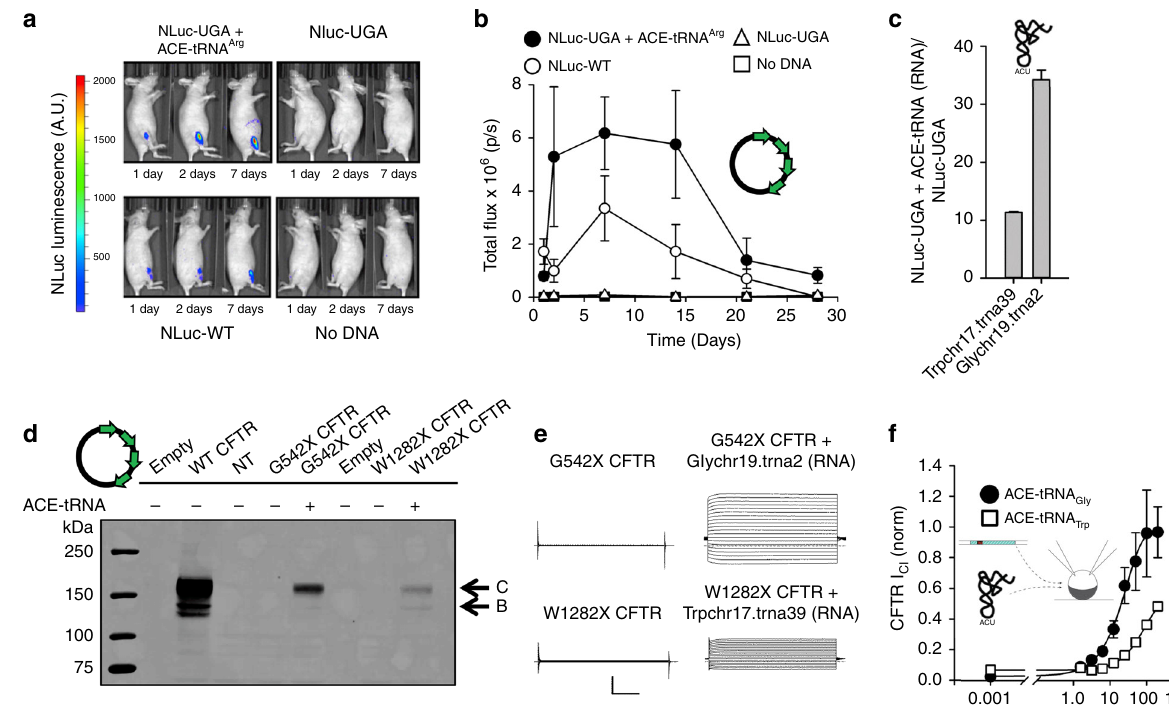
Fig. 5 In vivo delivery and suppression with ACE-tRNA as cDNA and RNA. a Representative images of mice injected with NLuc-UGA with ACE-tRNA Arg (Arg-chr9.trna6 UGA) or pUC57 empty vector, NLuc-WT or water in the tibialis anterior muscle followed by electroporation at days 1, 2, and 7 after DNA administration. b Quanti fi cation of luminescence emission by the tibialis anterior muscles of the abovementioned mouse groups at different timepoints after DNA injection and electroporation ( n = 3 mice per group, data are shown as SEM). c Rescued luminesce of stably expressed NLuc – UGA following transfection of Trpchr17.trna39cRNA and Glychr19.trna2 RNA transcripts ( n = 3 for each ACE-tRNA). d Representative western blot analysis of CFTR protein expressed in HEK293 cells 36 h following transfection of WT, G542X, G542X + Glychr19.trna2, W1282X and W1282X + Trpchr17.trna39 CFTR cDNA. e Exemplar families of CFTR Cl - current traces recorded using two-electrode voltage-clamp, 36 h following injection with WT, G542X, G542X + ACE-tRNA-Glychr19.trna2, W1282X and W1282X + ACE-tRNA-Trpchr17.trna39 CFTR cRNA. Currents were elicited using 5 mV voltage steps from − 60 to + 35 mV. The vertical and horizontal scale bars indicate 10 µ A and 50 ms, respectively. f Dose response of G542X ACE-tRNA Gly ( fi lled circles; n = 11 – 19) and W1282X ACE-tRNA Trp (open squares; n = 17 – 22) rescue (CFTR Cl - currents elicited at + 35 mV were normalized to WT CFTR Cl - currents at